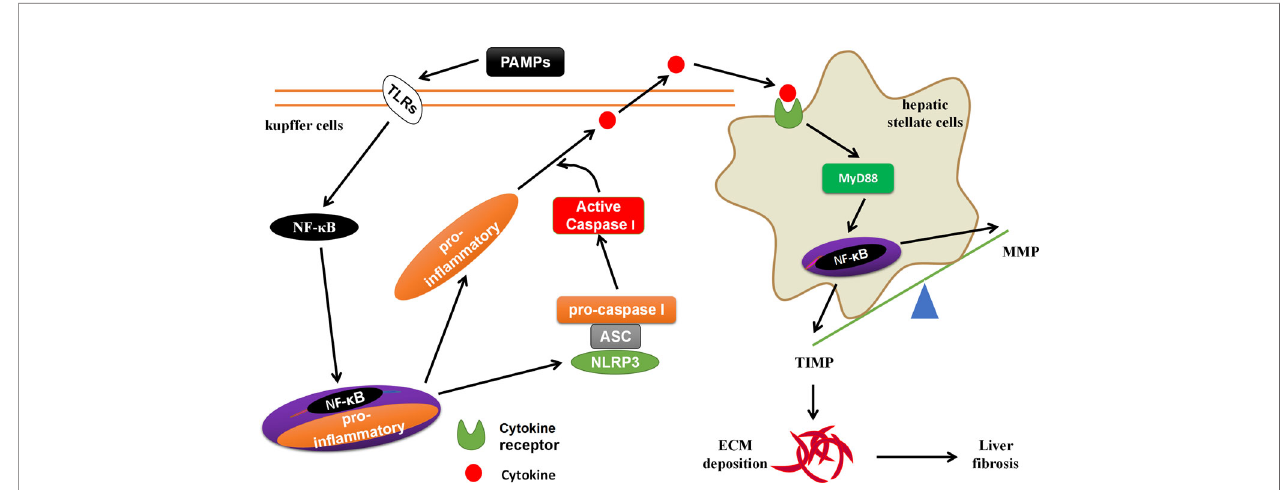
FIGURE 4 | The crosstalk between KCs and HSCs. The PAMPs in the leakage of chronic liver disease can activate NF- k B through TLRs on the surface of KCs, promote the activation of NLRP3 in fl ammasomes, and induce the generation of pro-in fl ammatory signals. These pro-in fl ammatory signals activate HSCs through cytokine receptors (CKRs)/myeloid differentiation factor 88 (MyD88)/NF- k B, leading to liver fi brosis-related molecules matrix metalloproteinases (MMP) and tissue inhibitor of metalloproteinases 1 (TIMP) imbalance, promote ECM deposition and form liver fi